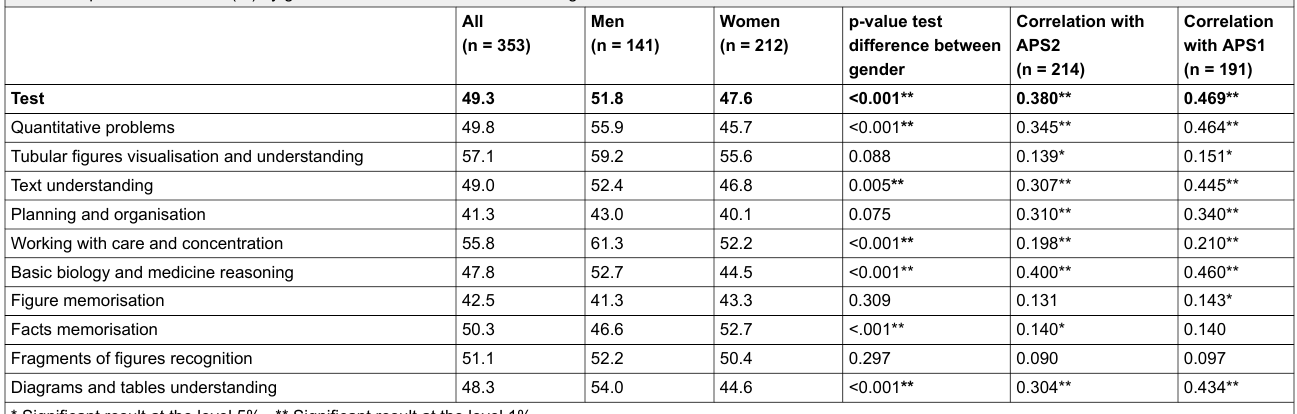
Table 1: Aptitude test scores (%) by gender and correlation with APS during Bachelor Year 1.